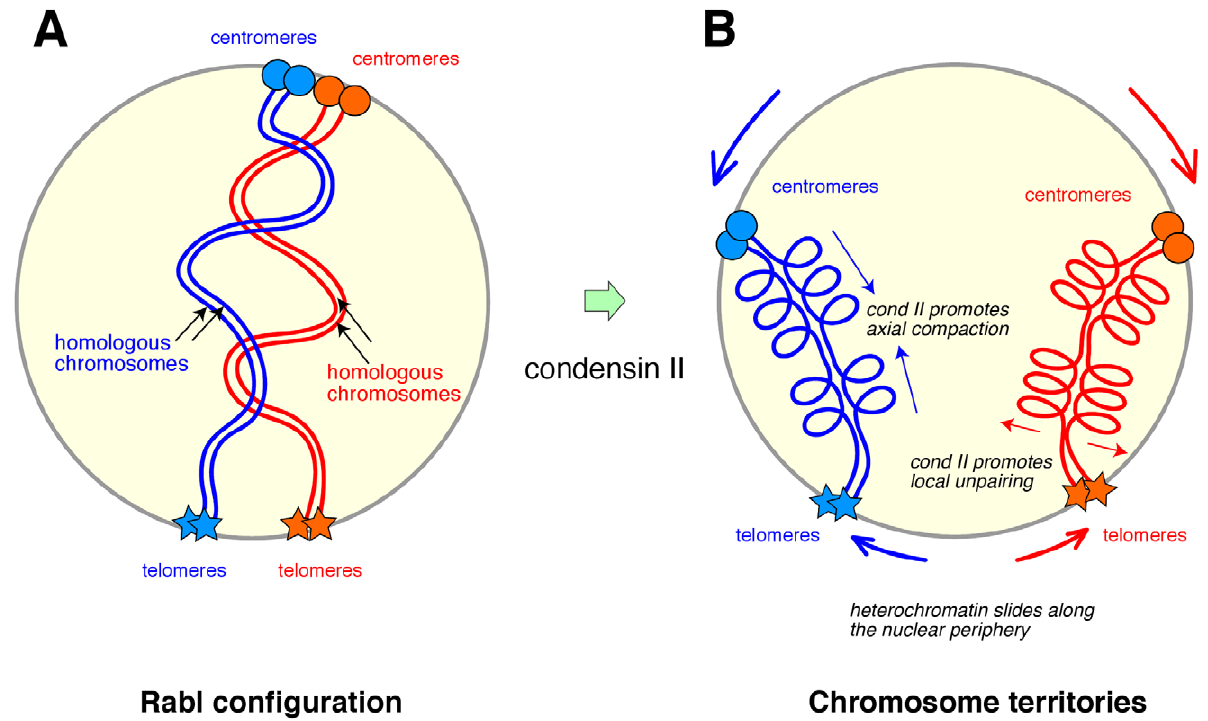
Figure 1. A model for how condensin II might contribute to the formation of chromosome territories in diploid cells. (A) After mitosis, decondensed chromosomes adopt the Rabl configuration, in which the centromeric regions (circles) of all chromosomes cluster near the nuclear periphery and the telomeres (stars) cluster near the opposite side of the nucleus. This configuration reflects the orientation of chromosomes in previous anaphase. In Drosophila diploid cells, homologous chromosomes pair along their lengths. For simplicity, only one arm of each chromosome is drawn here. (B) According to the model proposed by Bauer at al. [3], condensin II promotes axial compaction of the chromosome arms. Coincidentally, centromere clustering is dissolved, allowing heterochromatic regions (represented by the centromeres and telomeres) to slide along the nuclear periphery. As a natural consequence of these two conditions, each pair of homologous chromosomes is sequestered into a discrete chromosome territory. Intrachromosomal folding mediated by condensin II helps disrupt interchromosomal interactions, thereby promoting unpairing of homologous chromosomes and antagonizing transvection. The basic idea presented here could potentially be applied to diploid cells in other organisms where the pairing of homologous chromosomes is not necessarily